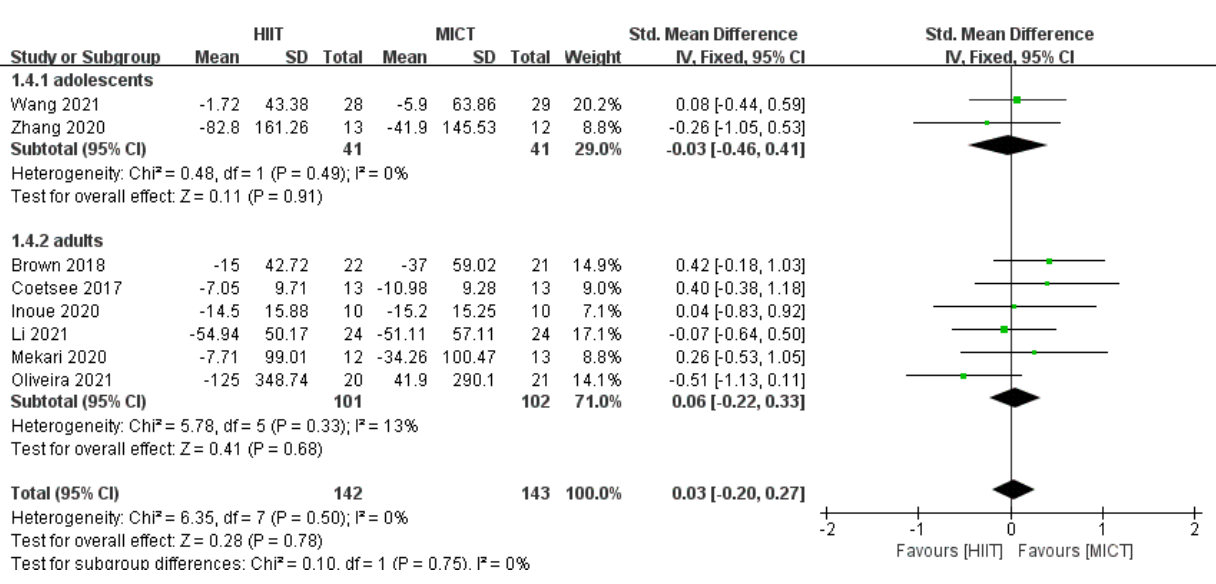
Figure 8. Subgroup analysis of HIIT and MICT on the response time of the intervention population [24,25,31-36].